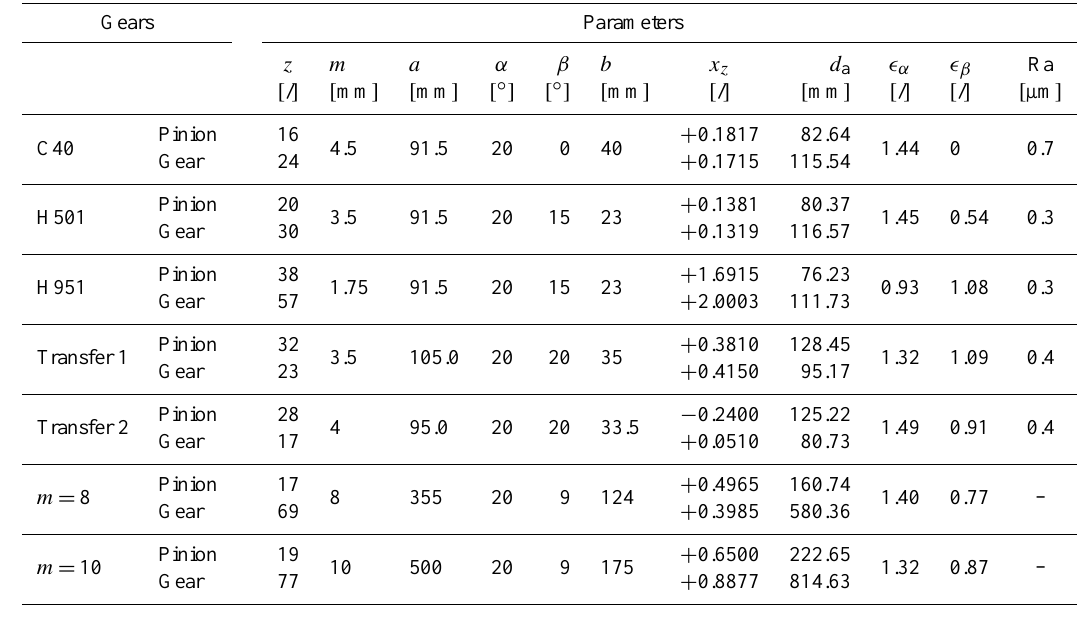
Table 1. Geometrical parameters of the gears.